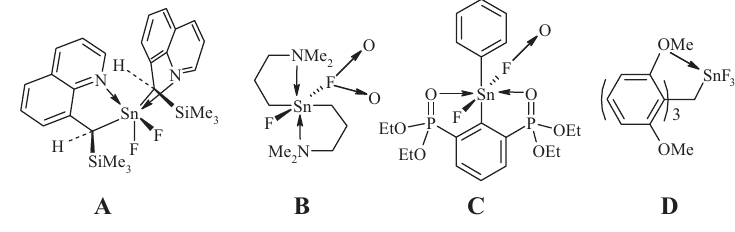
Figure 1 Structure of monomeric diorganotin difl